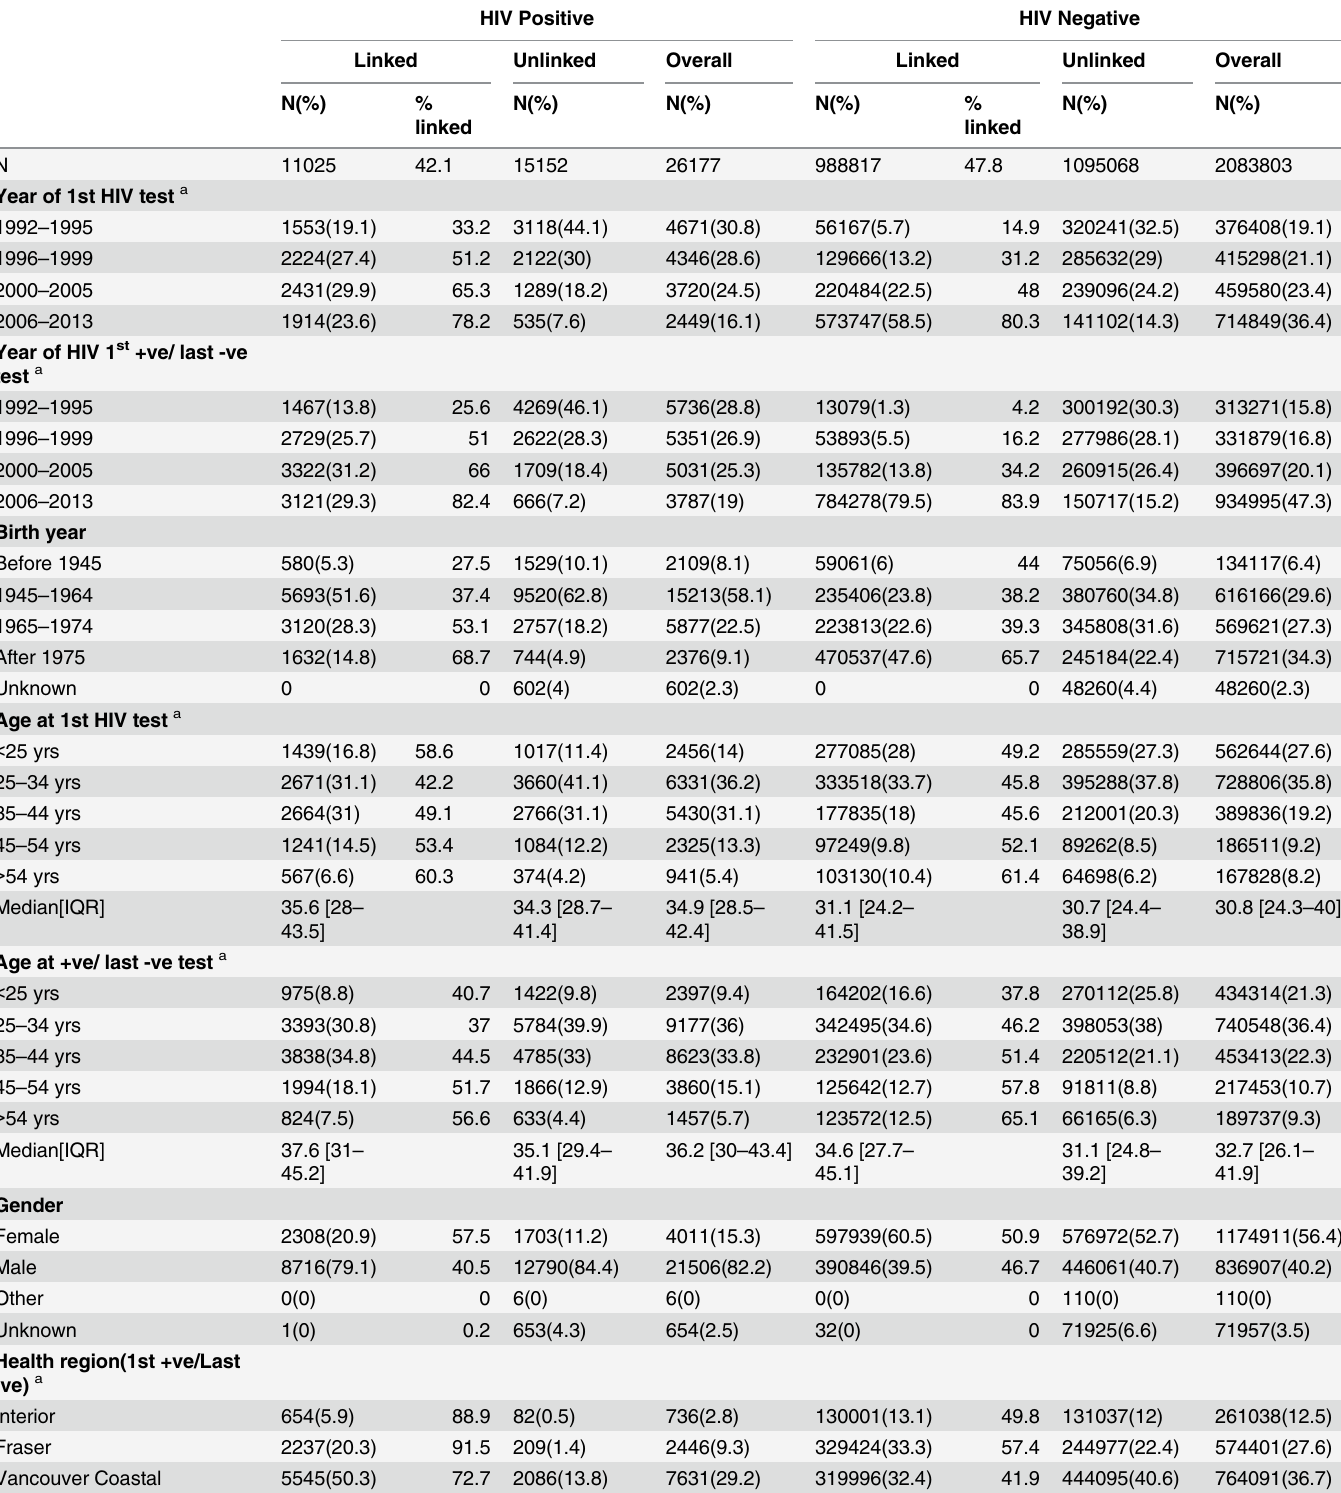
Table 4. Comparison of linked and unlinked HIV